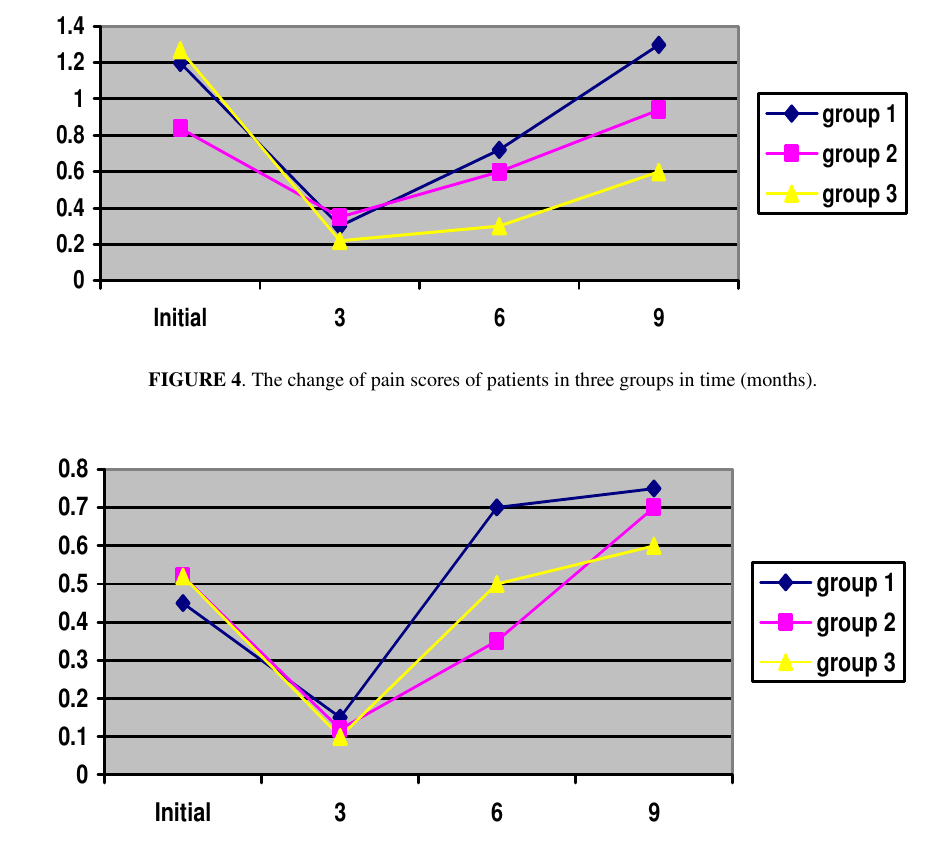
FIGURE 5 . The change of performance scores of patients in three groups in time (months).